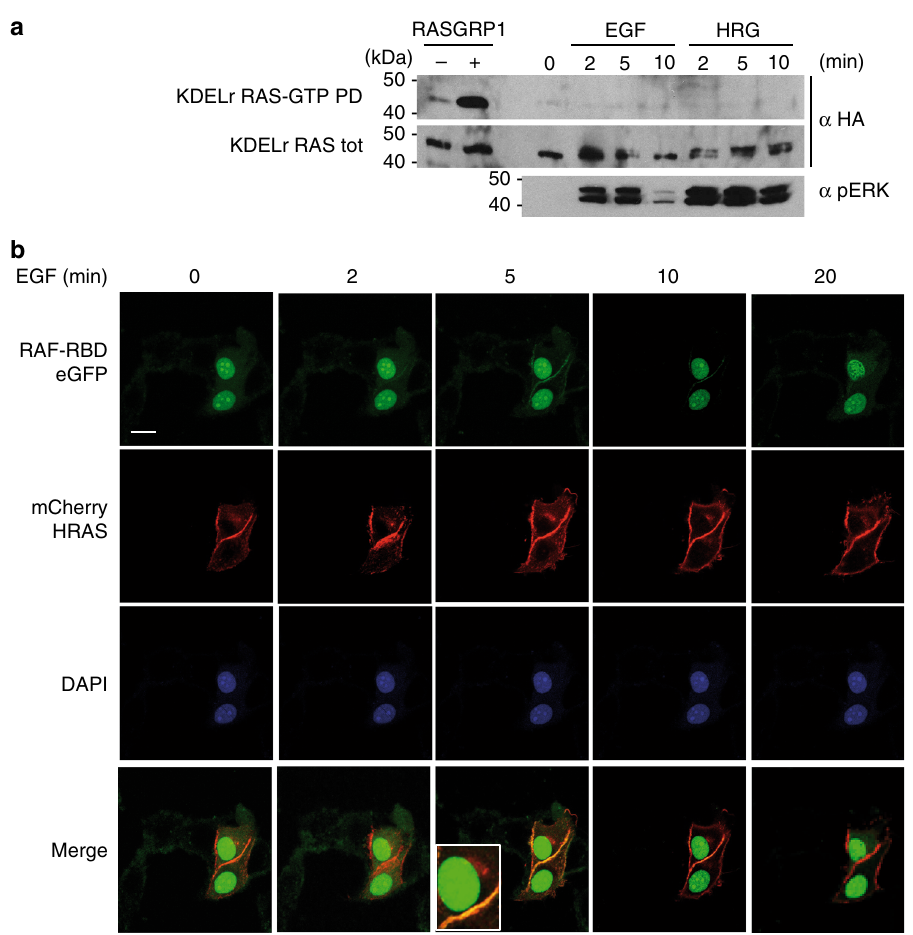
Fig. 1 GC RAS response to proliferative stimuli. a RAS is not activated at the GC by proliferative stimuli. MCF-7 cells transfected with HA-tagged KDELr HRAS (0.5 μ g), unstimulated (0) or treated with EGF (50 ng/ml) or HRG (30 ng/ml) for the indicated times. Cells transfected with RASGRP1 (1 μ g) ( + ) serve as positive control. GTP loading was assayed by GST-RBD pull-down (RAS-GTP-PD). b RAS activation by EGF is restricted to the plasma-membrane. MCF-7 cells transfected with constructs expressing cherry-HRAS and the RAS-GTP biosensor E3-R3 (RAF-RBD) (1 μ g each) and stimulated for the indicated times. Scale bar = 10 μ